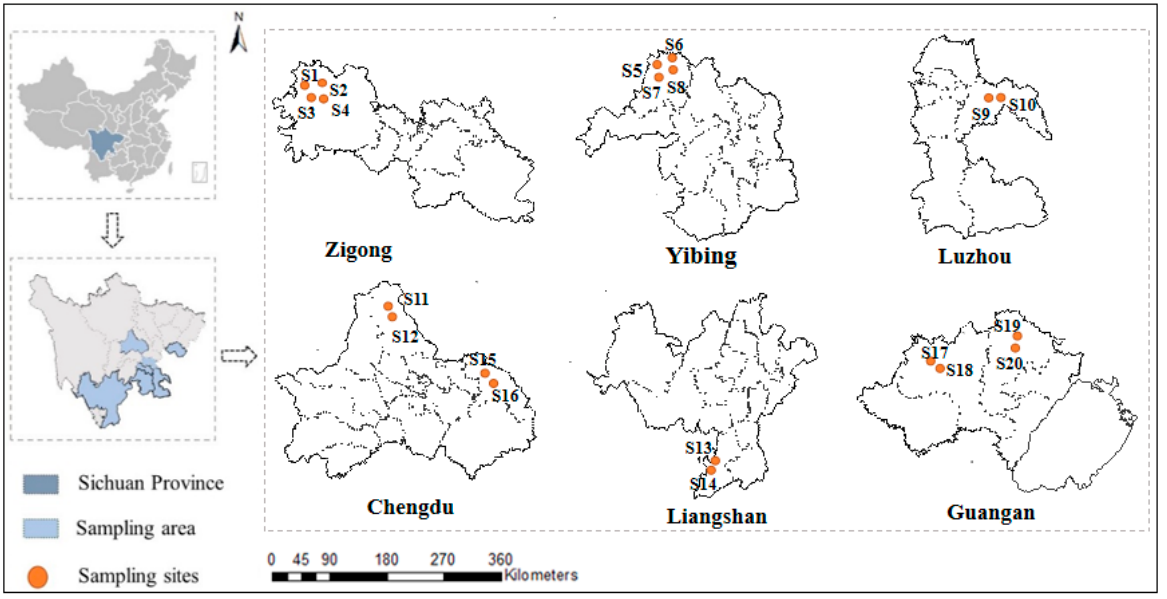
Figure 1. Schematic diagram showing the sampling sites in Sichuan Province.